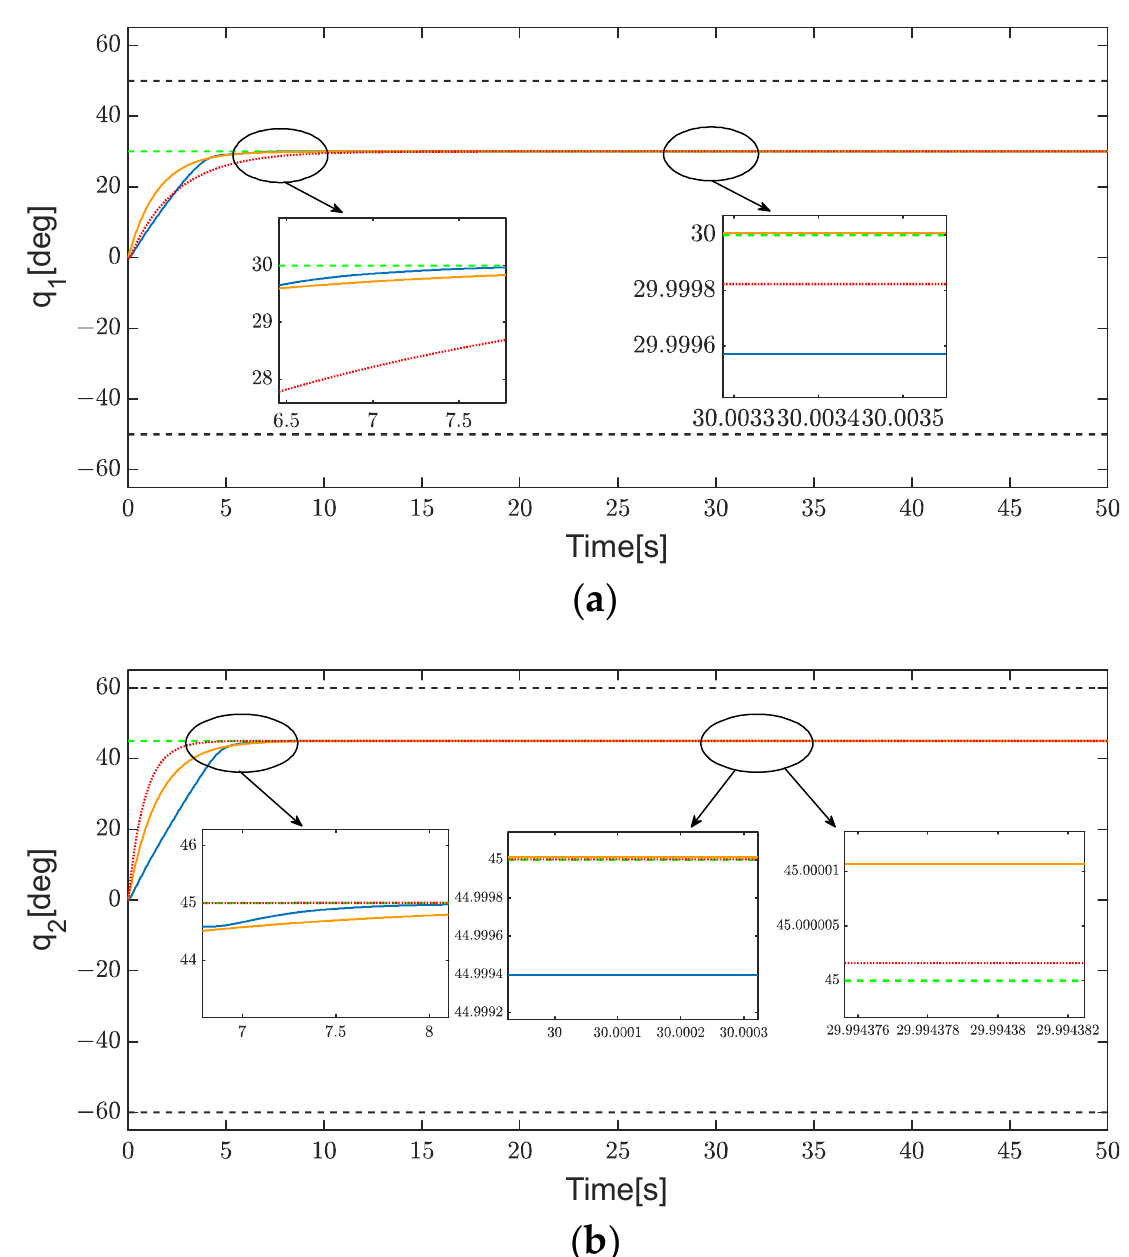
Figure 6. Comparison of angular position to [26,33] in case 1: [26] scheme (yellow solid line), [33] scheme (red dash line), the proposed scheme (blue solid line), the reference angular position (green dashed line), the angular position constrains (black dashed line); ( a ) Joint 1. ( b ) Joint 2.